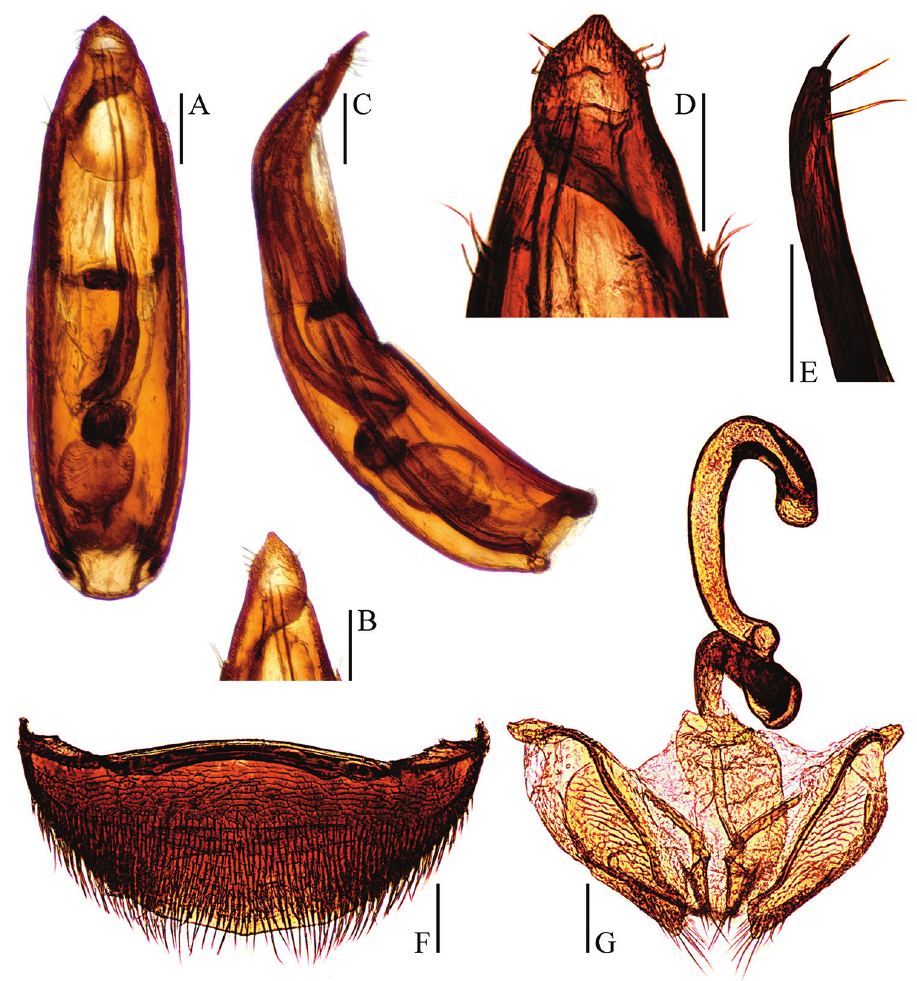
Figure 9. Ptomaphagus (s. str.) haba sp. n. ( ♂ : paratype; ♀ : paratype). A aedeagus (dorsal view) B aedea- gal apex (dorsal view) C aedeagus (lateral view) D aedeagal apex (ventral view) E paramere apex (lateral view) F ventrite VIII ♀ (ventral view) G spermatheca, genital segment and ovipositor (ventral view). Scale bars: 0.1